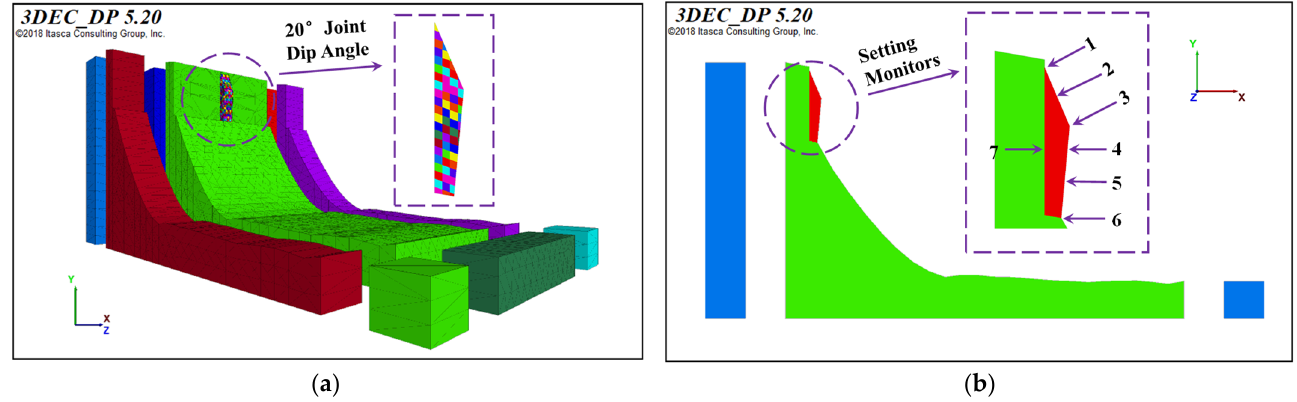
Figure 7. Numerical model of the high ‐ steep slope in 3DEC ( a ) and the locations of the monitors ( b ).